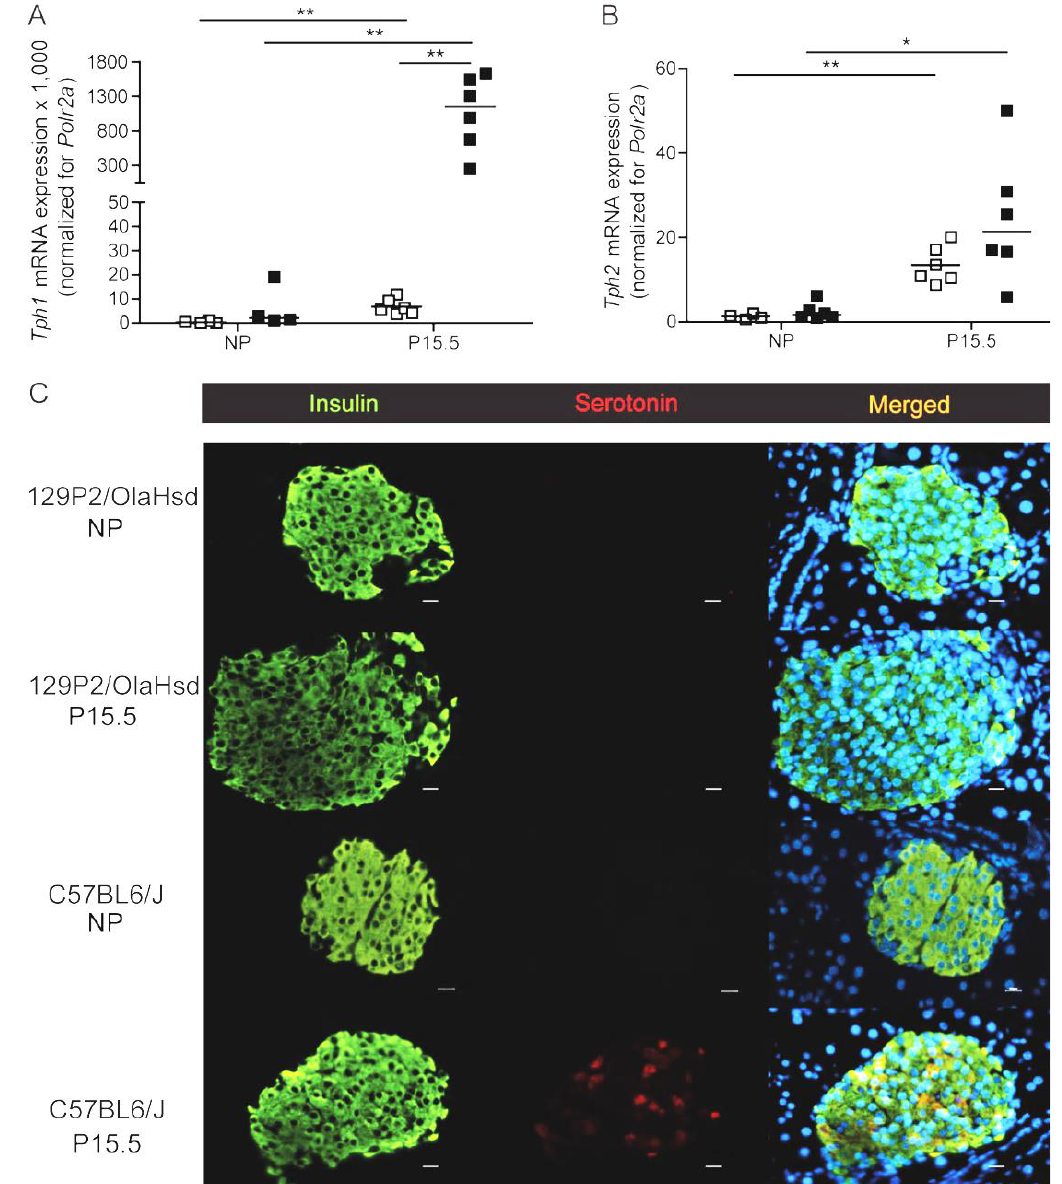
Figure 4. Expression of tryptophan hydroxylase and serotonin immunoreactivity in non-pregnant and pregnant 129P2/OlaHsd versus C57BL6/J mice. Measurement of expression signals of Tph1 ( A ) and Tph2 ( B ) in pancreatic islets isolated from 129P2/OlaHsd mice ( ☐ ) versus C57Bl6/J mice ( ◼ ) was performed by Q-RT-PCR. Each point in A – B represents the measurement of material sampled from one mouse; mean values are represented by horizontal bars. Data were normalized for the housekeeping gene Polr2a and the signal ratio in islet from non-pregnant 129P2/OlaHsd mice was set at 1.0. Significance of differences between groups was calculated using the unpaired Student’s - t test * p < 0.05, ** p < 0.01. C: Absence of detectable islet serotonin immunoreactivity in pancreatic sections of 15.5 days pregnant 129P2/OlaHsd mice. Immunostaining for insulin (green) and serotonin (red) was performed on pancreatic sections of non-pregnant and P15.5 pregnant 129P2/OlaHsd compared with C57BL6/J mice. Nuclei are stained with DAPI (blue). Magnification 40×, scale bars 10 µm.